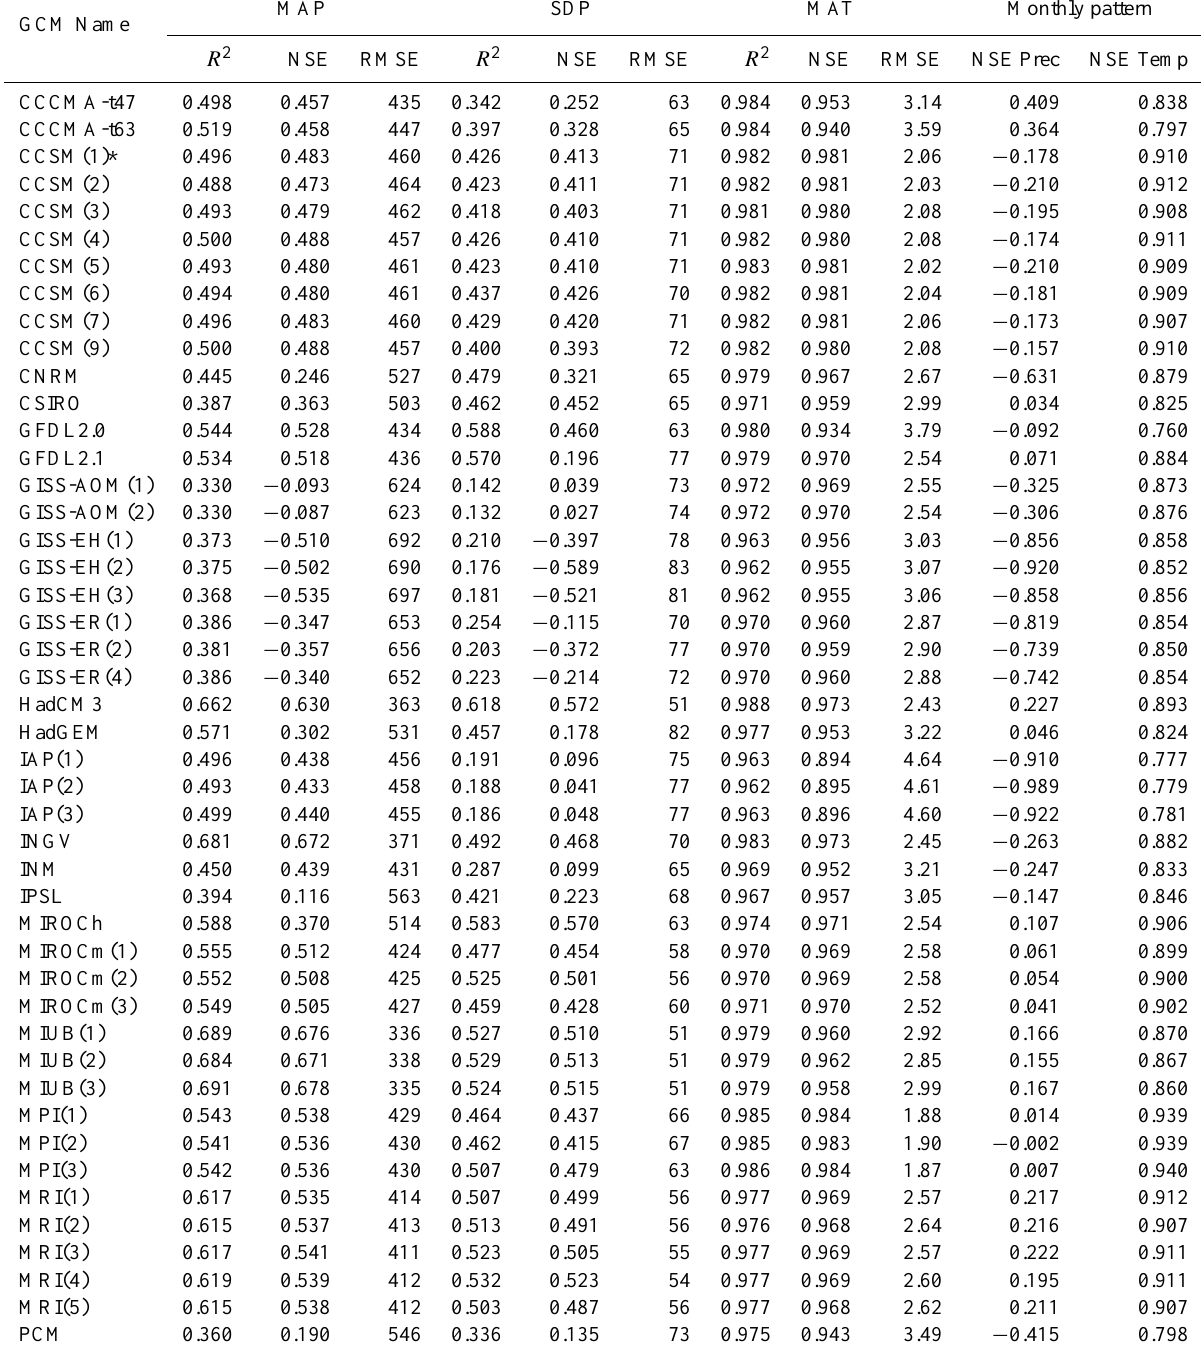
Table 4. Performance statistics comparing CMIP3 GCM mean and standard deviation of annual precipitation, mean annual temperature, and mean monthly patterns of precipitation and temperature with concurrent observed data. (Analysis based on untransformed